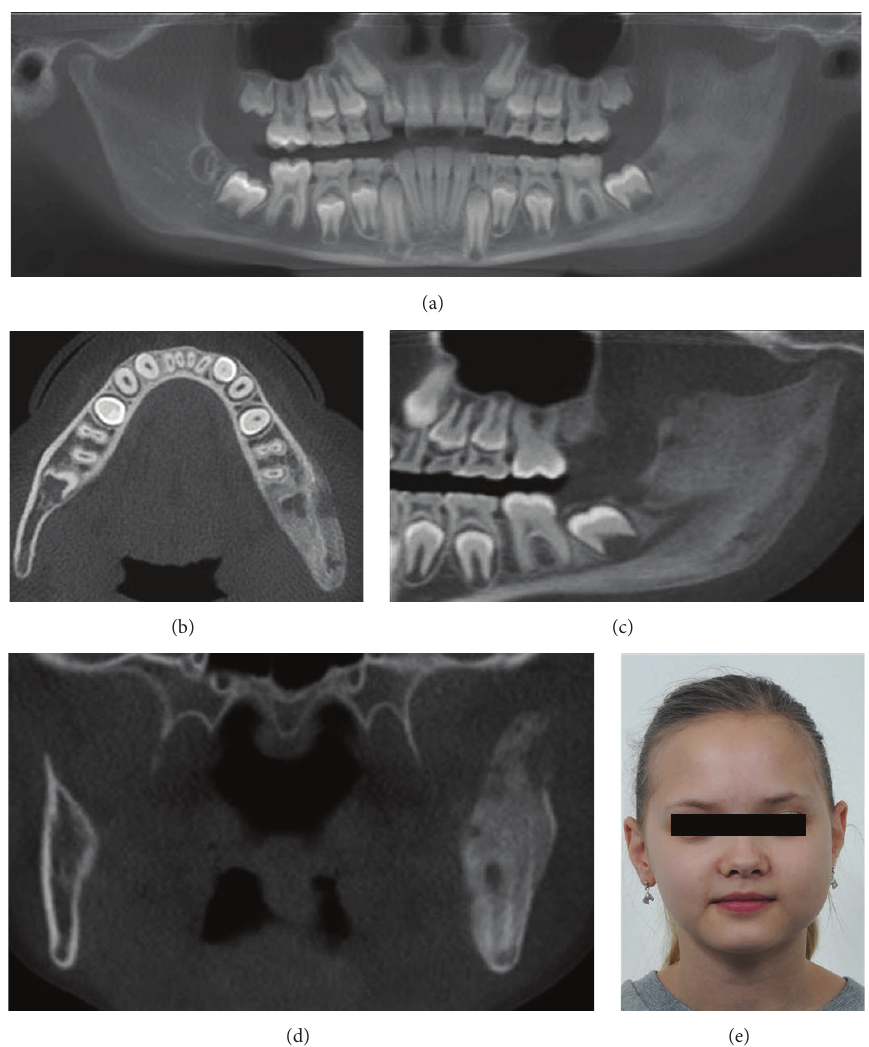
Figure 1: Preoperative CBCT and clinical image of patient case 1 with PCO. (a) Panoramic CBCT; (b, c, and d) axial, sagittal, and coronal sections of sclerotic mandible with new bone formation and lytic lesion at left posterior site; and (e) patient photo with swelling of the left side of the